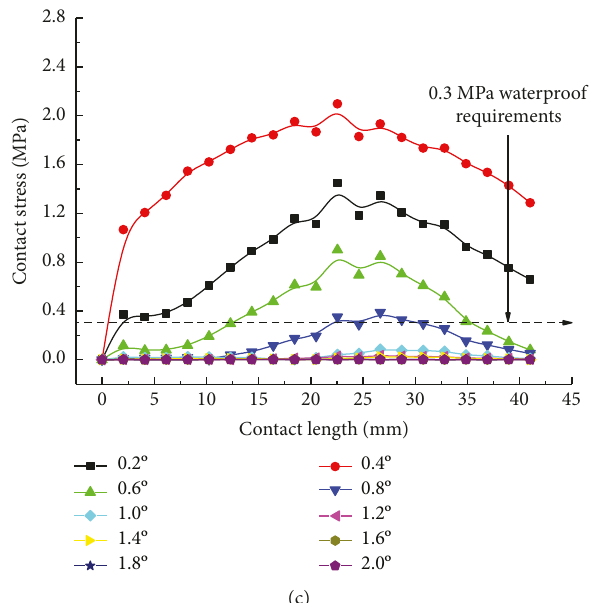
Figure 19: Contact stress curve of the first rubber ring after optimizing during clockwise rotation: (a) contact pressure of line 1 for the first rubber ring, (b) contact pressure of line 2 for the first rubber ring, and (c) contact pressure of line 3 for the first rubber